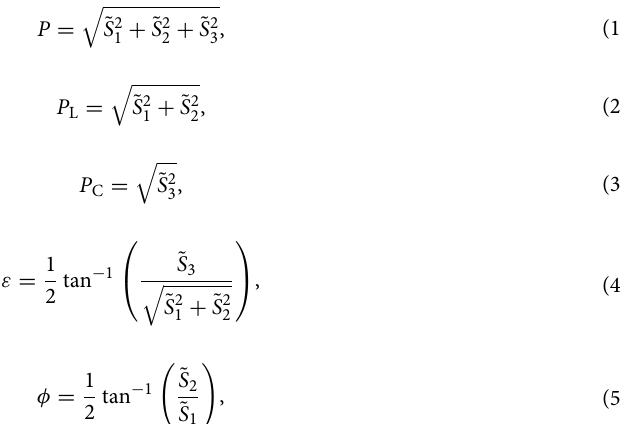
components with the same black color. We expected these two parts to be identified by the PPPI system. The prepared soldered condenser has eight soldered parts, including one bad quality part [see the dashed yellow circle in Fig. 3d] and seven good quality parts. We also expected to be able to detect the bad quality soldered part from the PI. Spatially divided images of orthogonal polarization components obtained by the PPPI sys‑ tem.